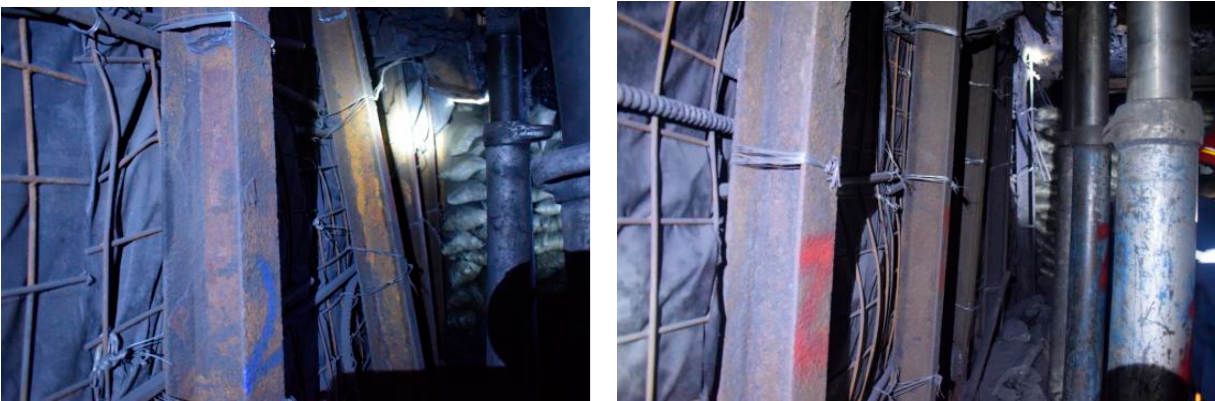
Figure 14. On-site retaining support effect.